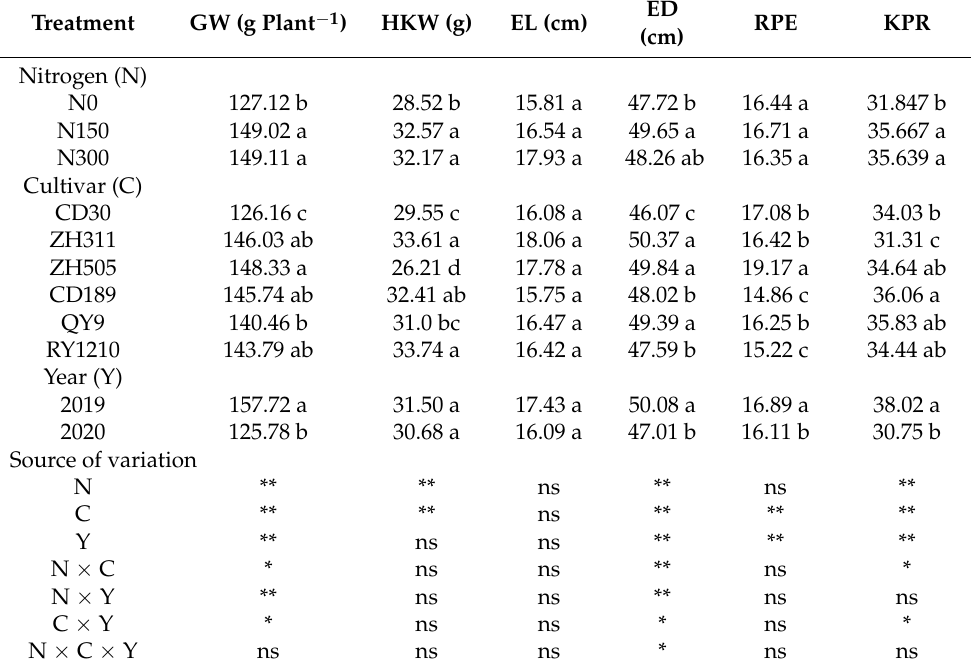
Table 2. Analysis of variance in GW, HKW, EL, ED, RPE and KPR on maize of six cultivars under three N